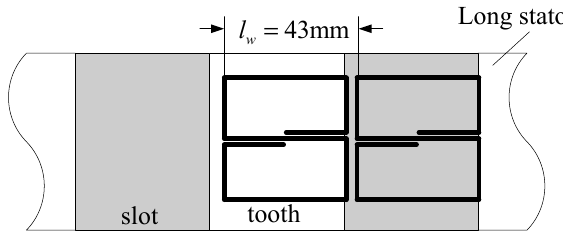
Figure 15. Difference coil